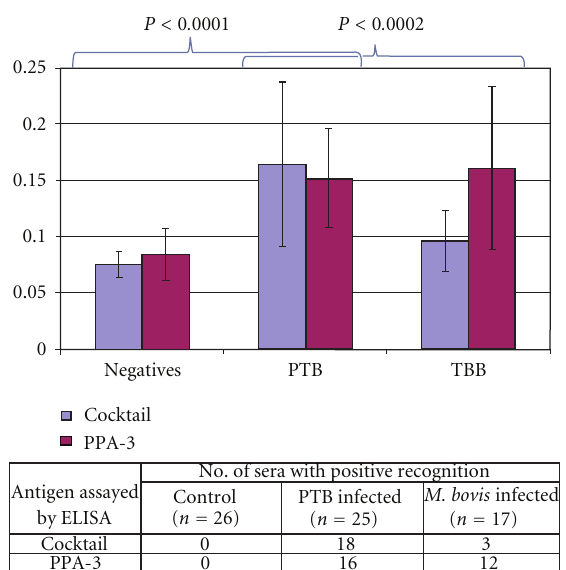
Figure 3: Reactivity of bovine sera to the cocktail by ELISA. Comparison of the diagnostic performance of using PPA-3 (Allied monitor) and the antigen cocktail (MAP 0038, MAP 0210c, MAP 1272, MAP 1693, MAP 2020, MAP 0209c, and MAP